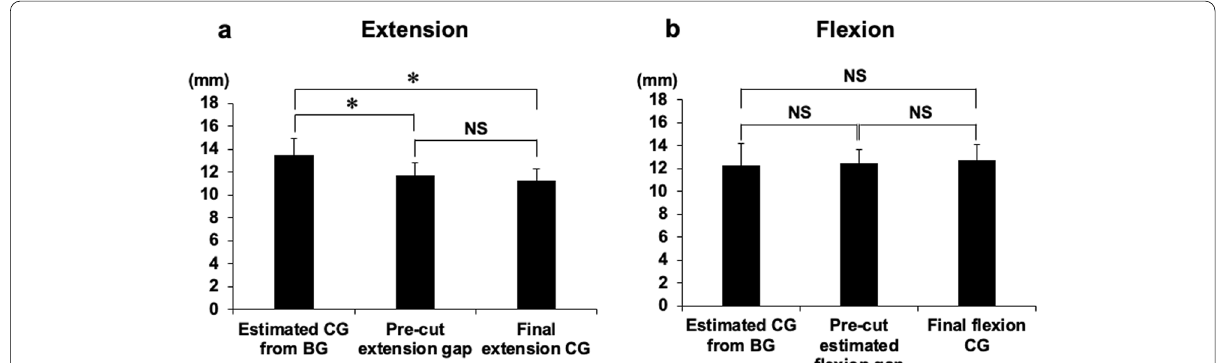
Fig. 5 Difference between BGs and CGs. Indicated is the difference between the estimated component gaps (CGs) from bone gaps (BGs), and the actual CGs with PS PCT and trial component at knee extension and flexion. The CGs estimated from BGs at knee extension (BG minus 9 mm) ( a ) and flexion (BG minus 10 mm) ( b ) were compared with the CGs with PS PCT and actual final CGs. (* P < 0.01). PS PCT, posterior-stabilised pre-cut trial